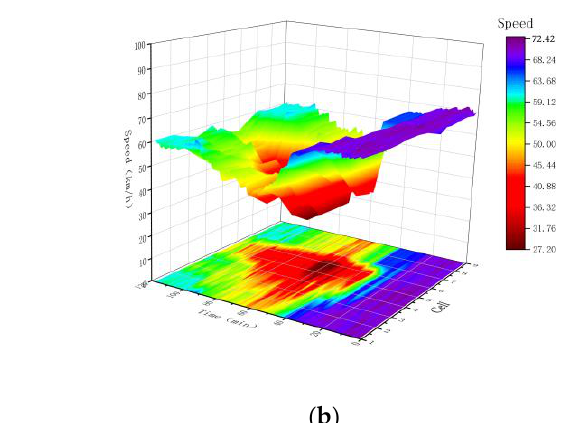
Figure 13. VISSIM simulation flow input. ( a ) VISSIM flow input operation interface; ( b ) Input flow distribution.